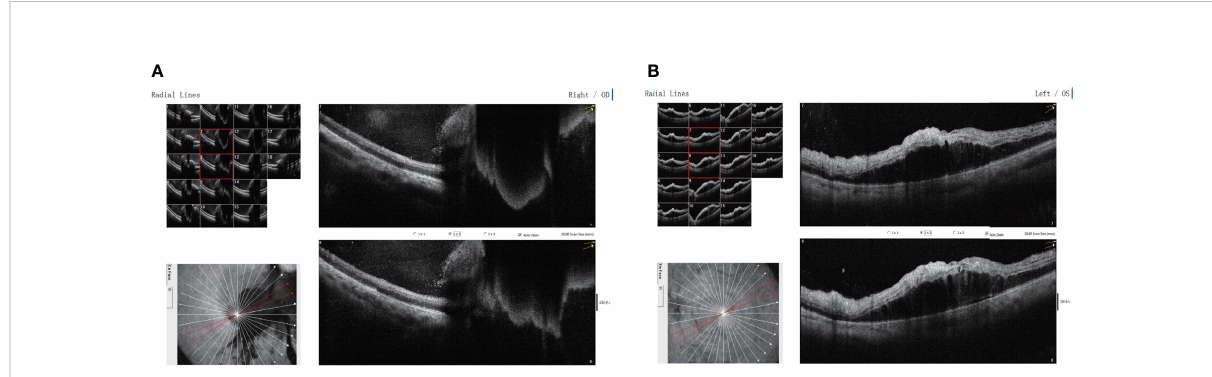
FIGURE 2 Binocular macular optical coherence tomography scanning through the (A) right and (B) left eyes showing disordered, uneven signals in the right macular region, with signi fi cant fl uid accumulation below the right eye and a small amount of fl uid bulge below the fovea of the left eye.